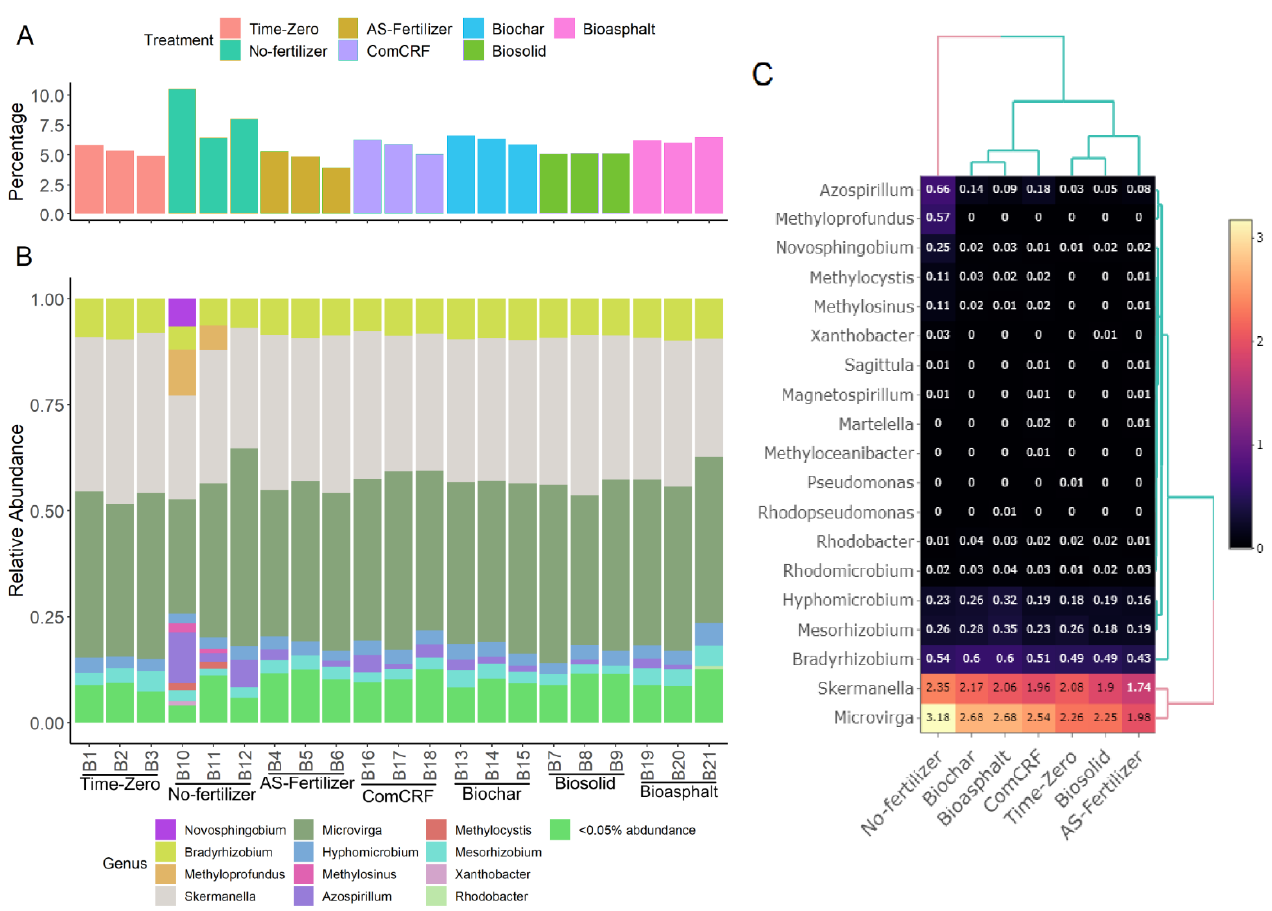
Figure 4. Distribution of Nitrogen-fixing genera across the treatments. Percentage of total OTU associated with nitrogen fixation ( A ); stacked bar plot showing distribution of N-fixing genera in each replicate ( B ), and heatmap showing distribution of genera and “ hclust ” hierarchical clustering of the treatments ( C ).